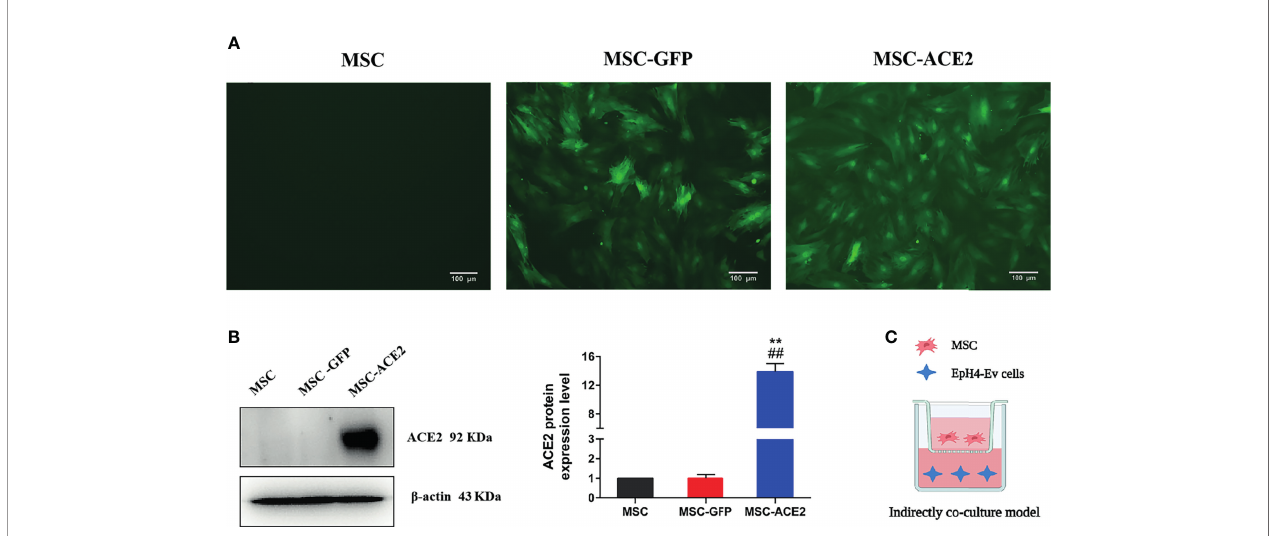
FIGURE 1 | Stable geneticmodi fi cation ofMSCs with a lentiviral vectormediates ACE2 gene transduction. (A) Examples of transduced MSC-ACE2 morphologyat passage 4 under phase control and fl uorescence microscopy, the transduction ef fi ciency as assessed bydetectingGFPexpression was as high as 100%. (B) The ACE2 protein expression in MSCs was assessed by Westernblot. Experiments were repeated three times and data were presentedas the mean ± SEM (n = 4). Approximately 12- fold higher levelswere represented in the MSC-ACE2 group than the MSC and MSC-GFPgroups (** P < 0.01 vs. MSC; ## P < 0.01 vs. MSC-GFP). (C) Anindirectco-culture model system was utilizedto examine the therapeuticimpact of MSC, MSC-GFP, as wellas MSC-ACE2 onresisting LPS-inducedinjuryin EpH4-Ev cells.